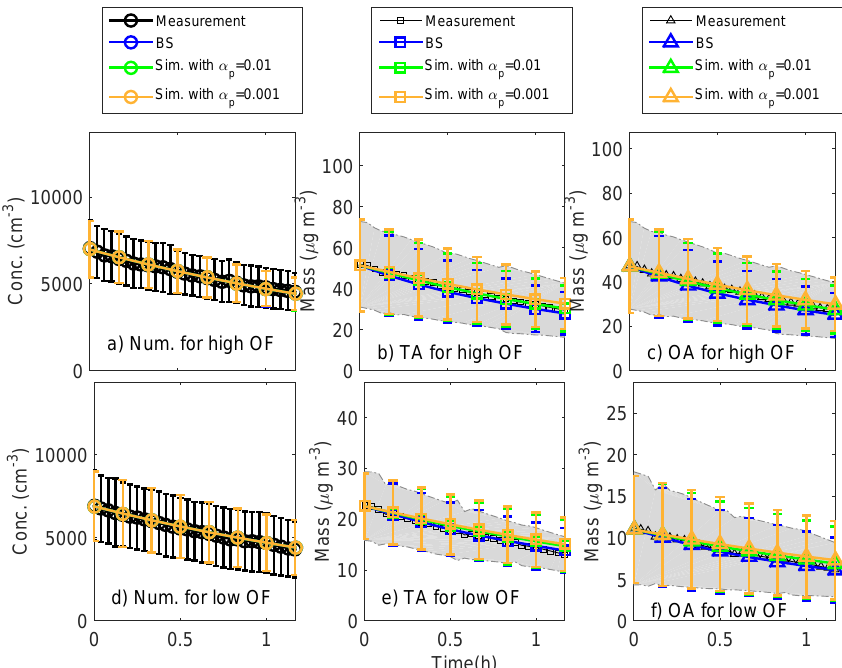
Figure 10. Similar to Fig. 2 except for the simulations with different accommodation coefficients of vapor with particles ( α p ) of 0.01 and 0.001.